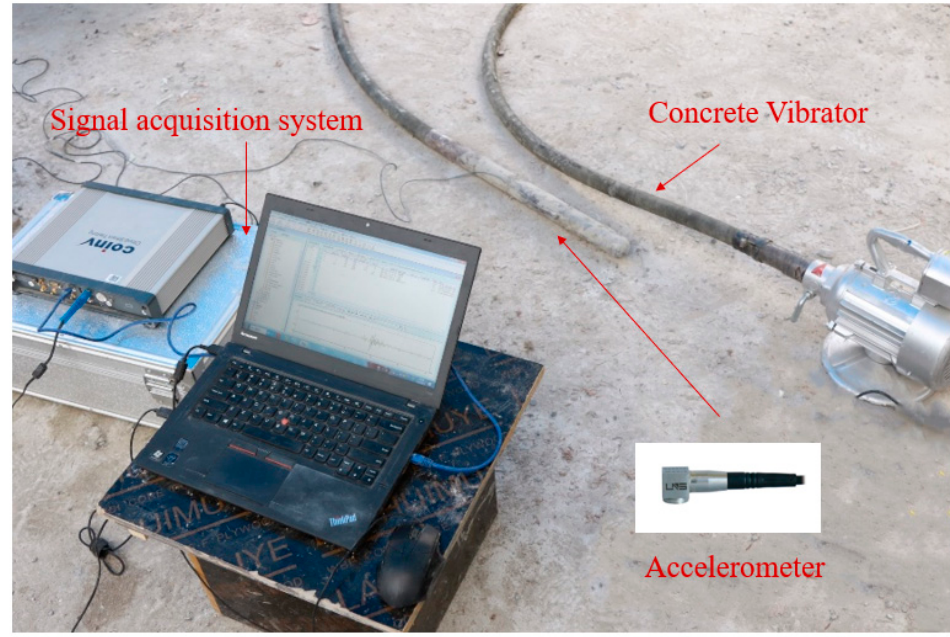
Figure 3. Signal Acquisition System and Accelerometer.